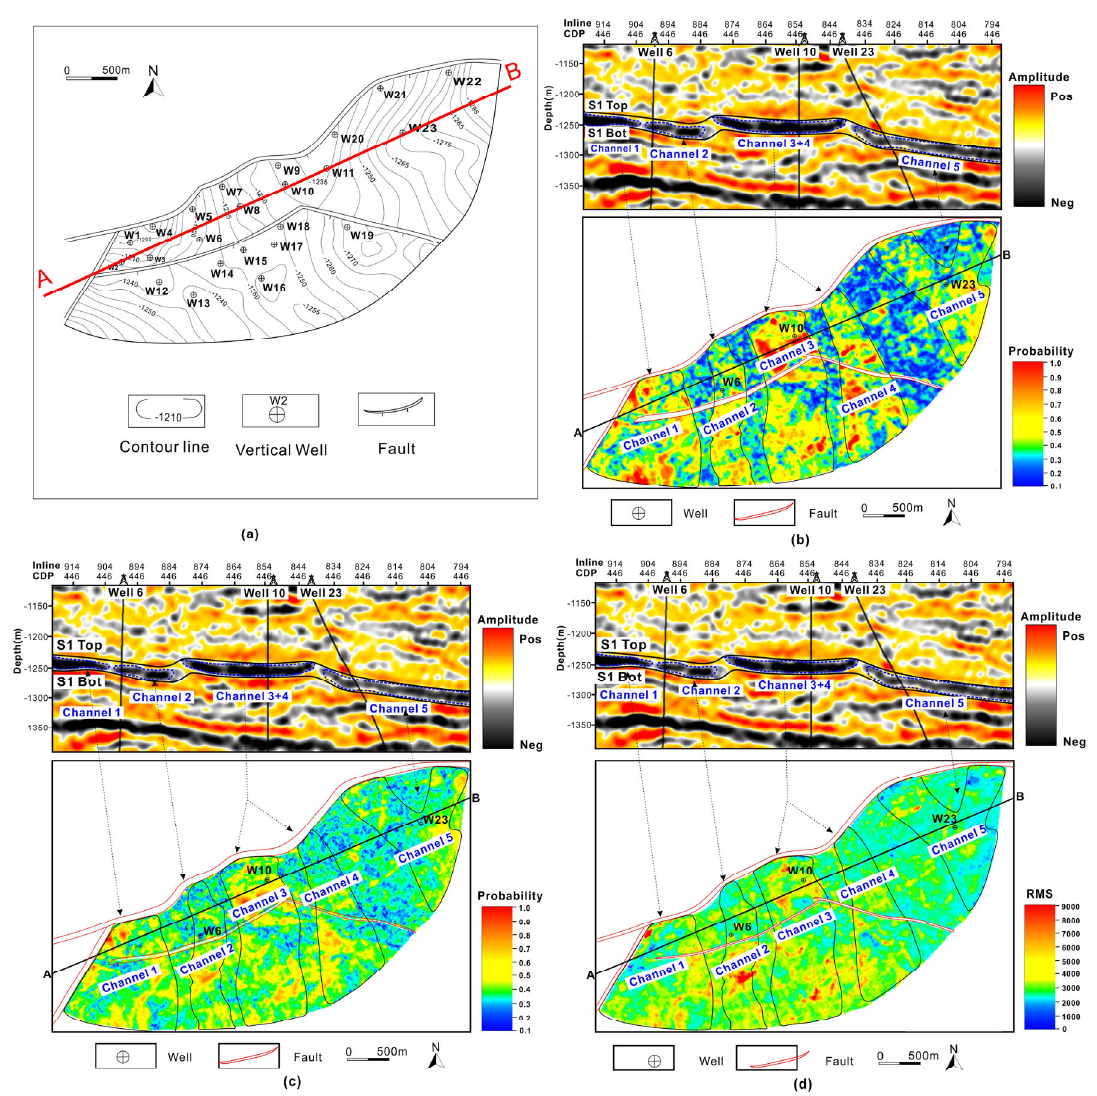
Figure 15. Comparison chart of braided river sandbodies prediction using different methods. ( a ) Projection of sectional location of the study area. ( b ) Seismic sections and spatial distribution of sand development probability obtained by the new method. ( c ) Seismic sections and spatial distribution of sand development probability obtained by traditional probability fusion method. ( d ) Seismic sections and spatial distribution of RMS amplitude.